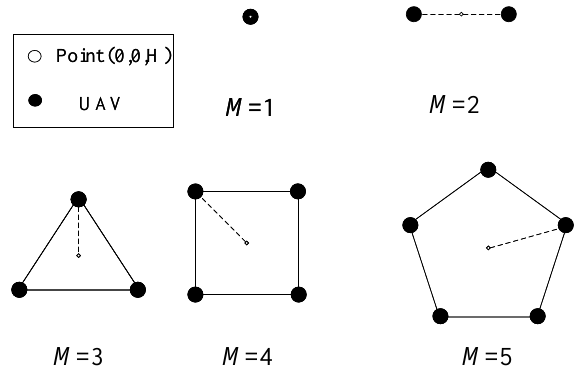
Figure 4. The optimal trajectory of UAVs in the scenario of K = 1 and M < 6.